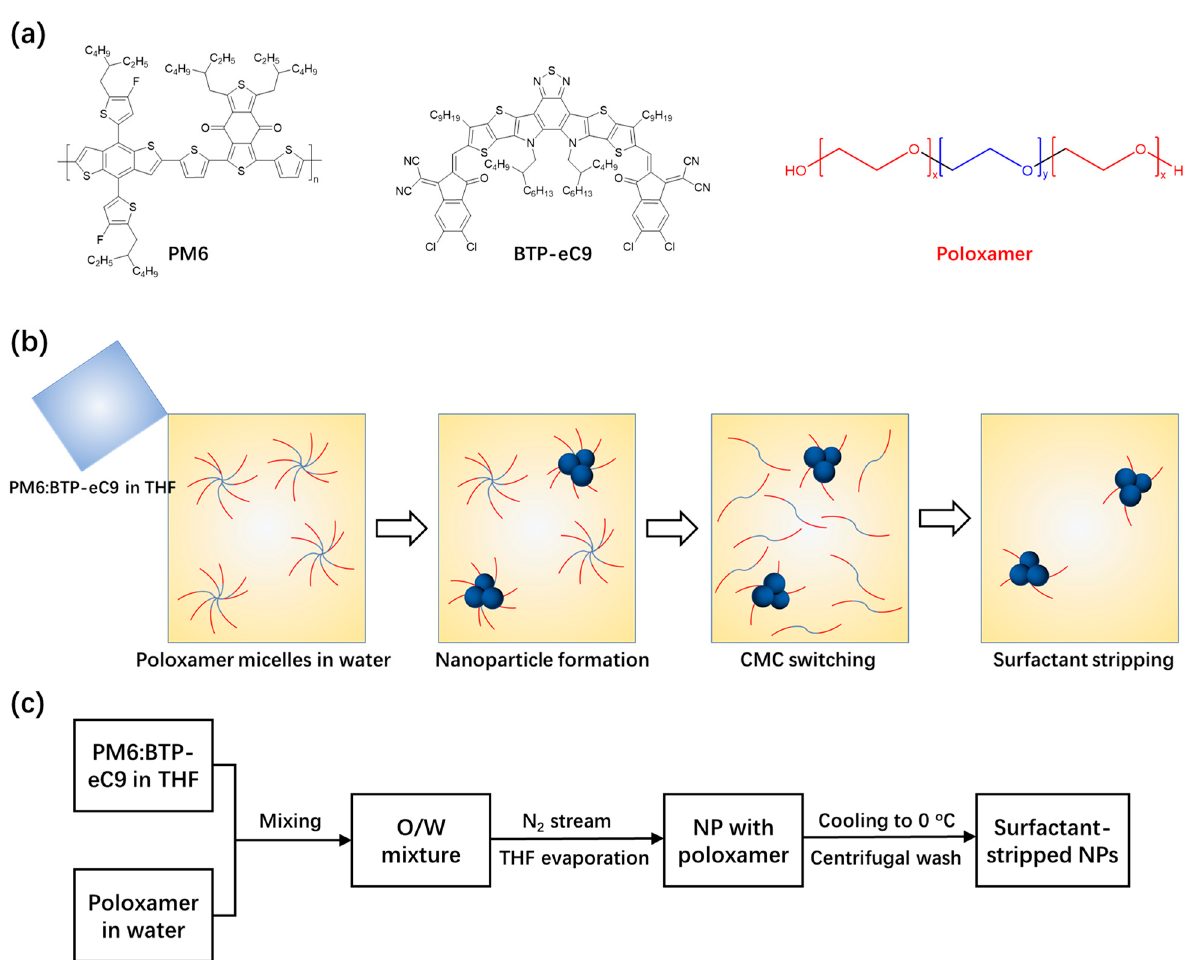
Figure 1. ( a ) Chemical structure of donor PM6, acceptor BTP − eC9, and surfactant poloxamer for ssNP synthesis; ( b ) synthesis and purification of ssNPs by temperature − mediated CMC − switching and the surfactant stripping strategy; and ( c ) flowchart of the ssNP synthesis.